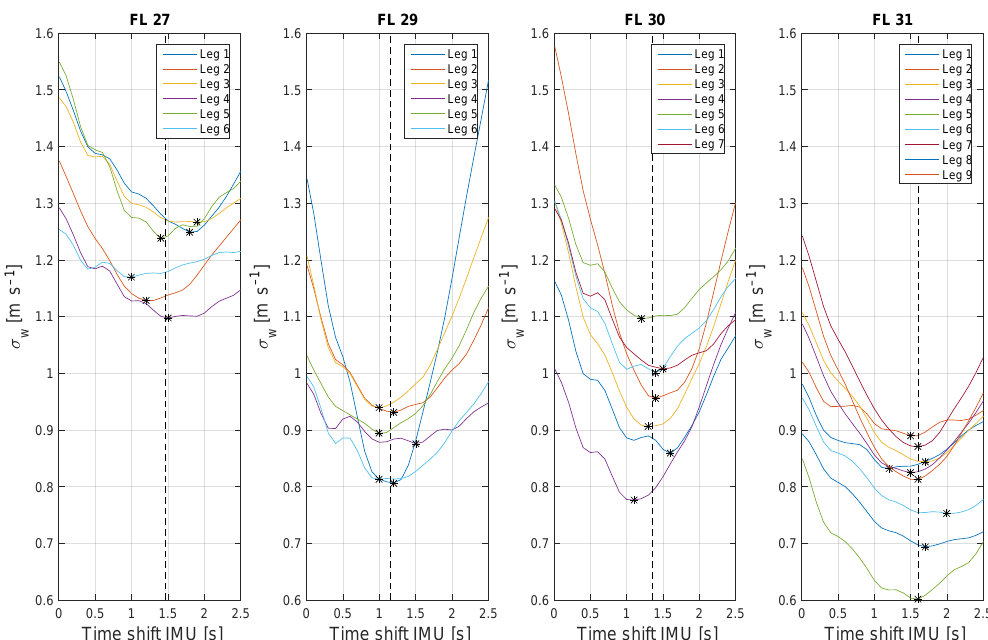
Figure 6. Example of the IMU time shift analysis for flight no. 27, 29, 30 and 31, showing the variation in σ w for the range of time shifts between 0 and 2.5s. The minimum value of σ w for each leg can be seen by the black asterisk. The average time shift for each flight is shown by the dashed vertical line.